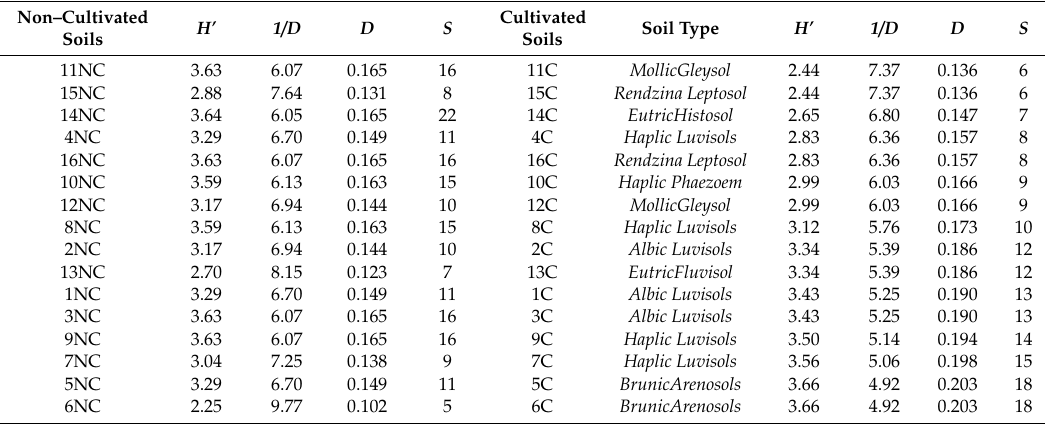
Table 4. Comparative biodiversity of Actinobacteria along a gradient of cultivated soils.